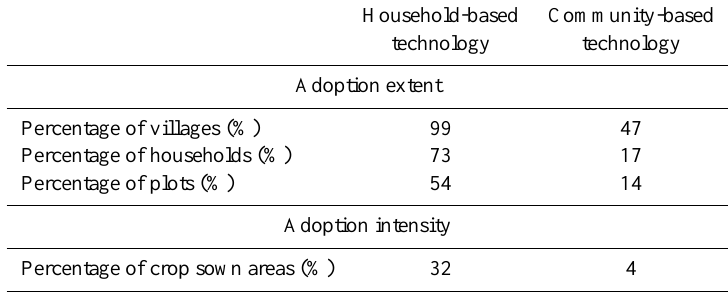
Table 2. The adoption extent and intensity of modern irrigation technology in China, 2010.